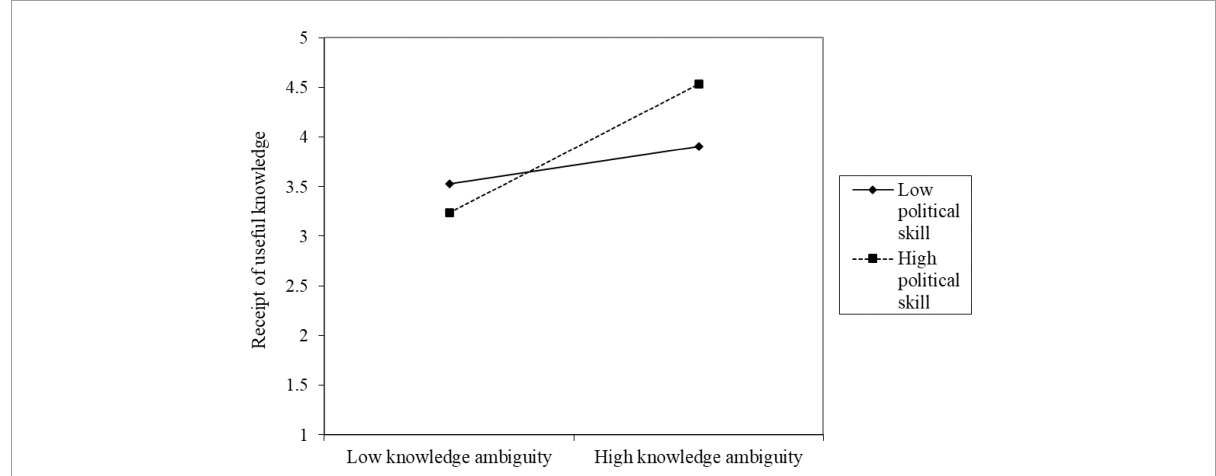
FIGURE4 Diagram of the interaction of political skills affecting knowledge ambiguity on receipt of useful knowledge.